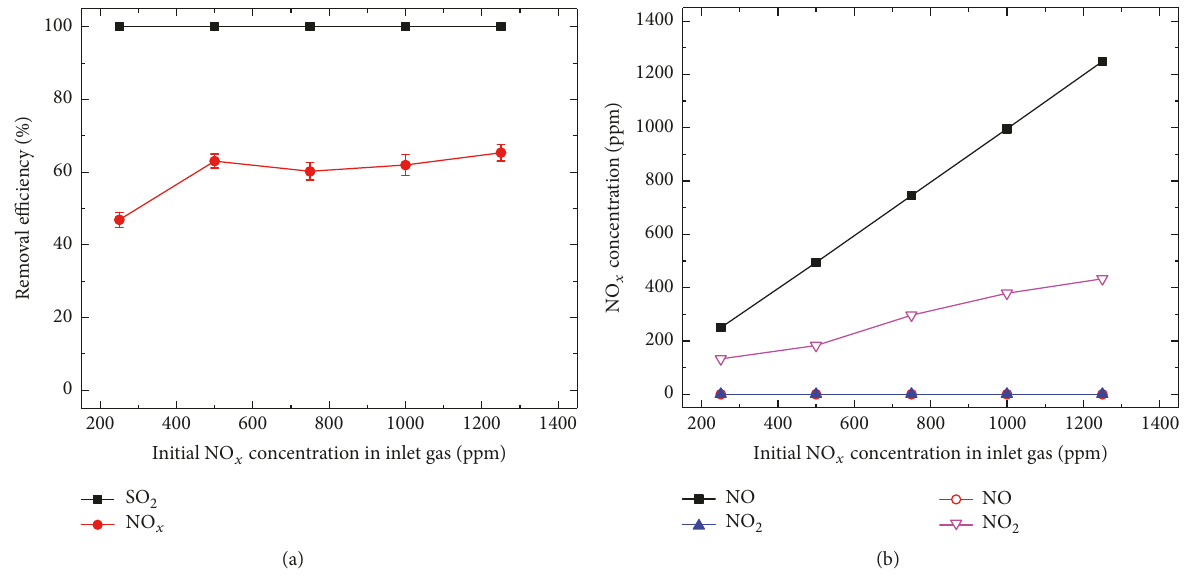
Figure 12: The change of (a) NO inlet SO 2 concentration is 600ppm, inlet NO solution temperature is 293 K; solid points refer to inlet NO